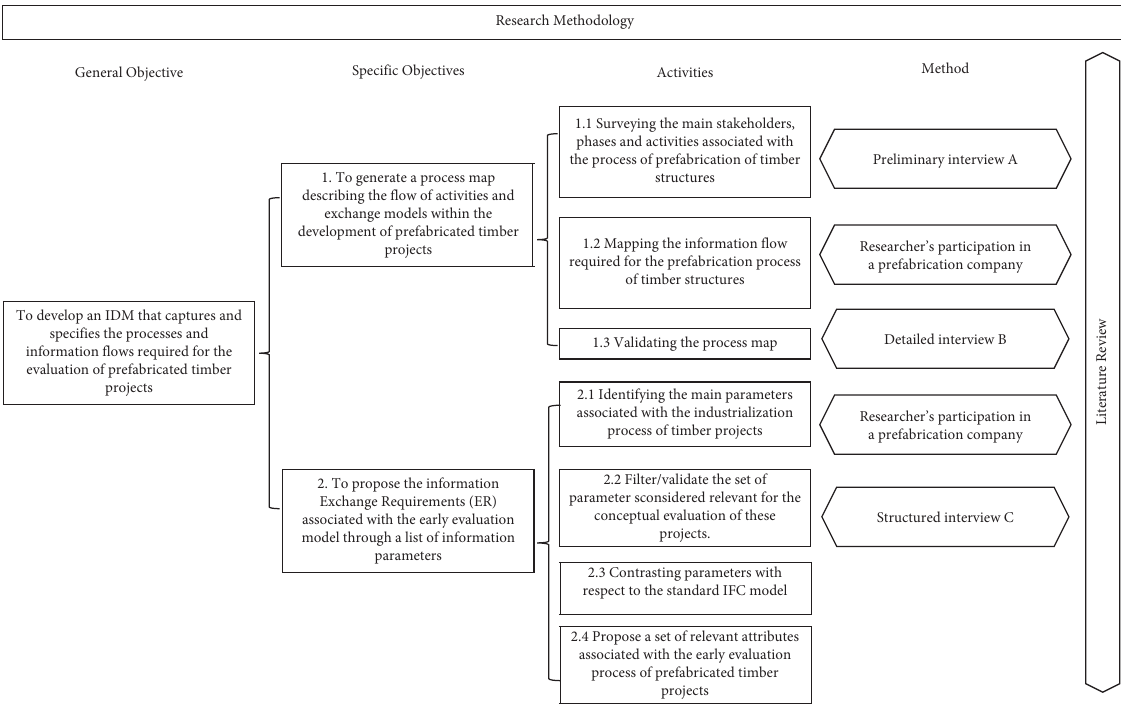
Figure 1: Research